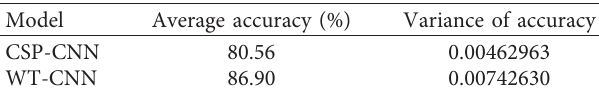
Table 5: Comparison of CSP-CNN and WT-CNN classification results.